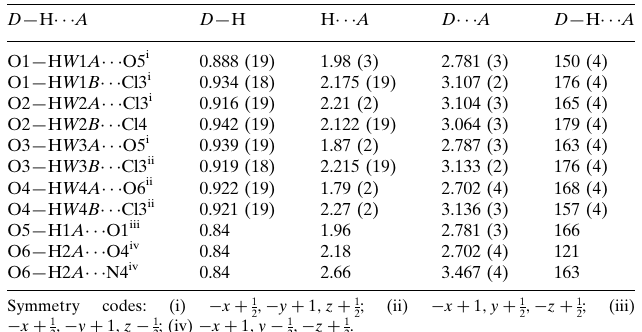
Hydrogen-bond geometry (A˚ , (cid:4)